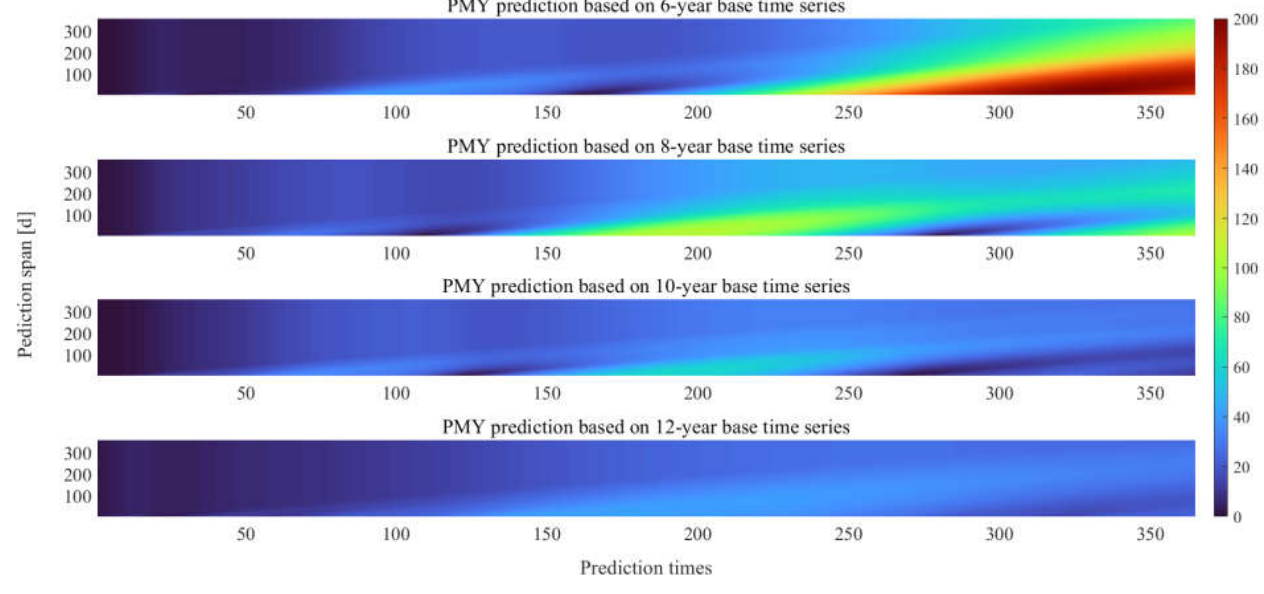
Figure 9. MAE (unit: mas) of PMY prediction using hybrid CNN–LSTM model based on different base time series.